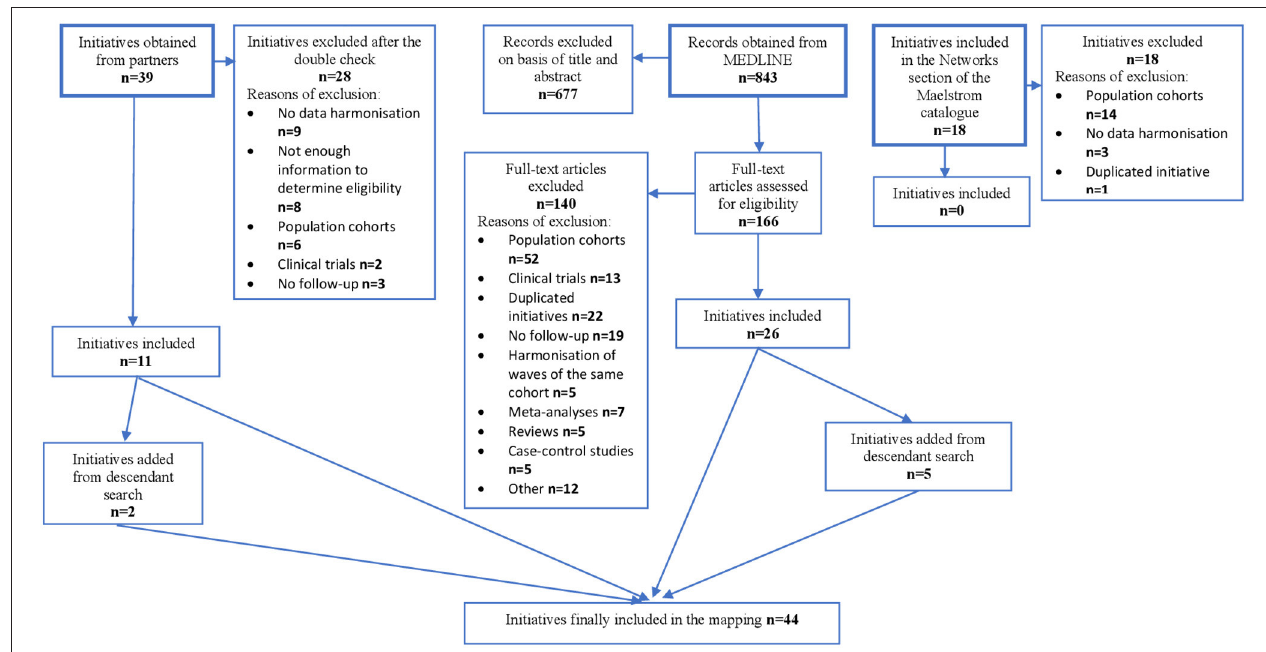
FIGURE 1 | Results of the search for harmonization initiatives of patient